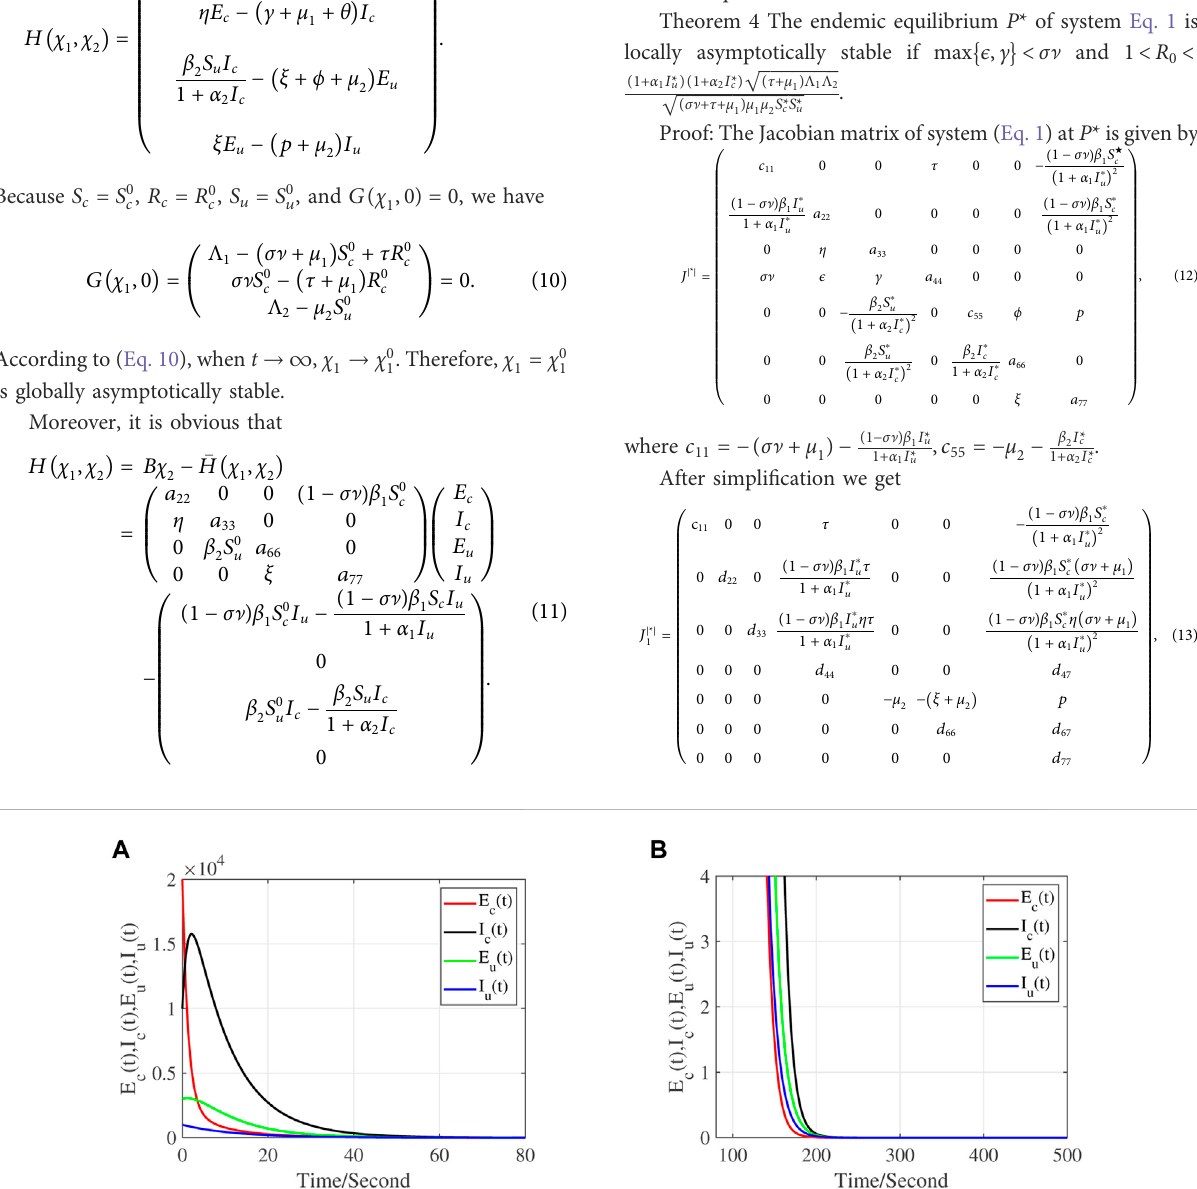
FIGURE 1 Time series plot of system (1) with Λ 1 =0.75, Λ 2 =0.1, σ = 0.6, ] = 0.1, β 1 = 0.035, β 2 = 0.035, α 1 =0.8, α 2 = 0.3, μ 1 =0.1, μ 2 = 0.1, τ = 0.1, η = 0.45, ϵ =0.25, ϕ =0.05, p =0.003, ξ =0.005, θ =0.001, γ =0.05. (A) thetendencyofthewormpropagationinashortperiod, (B) thetendencyoftheworm propagation in a later